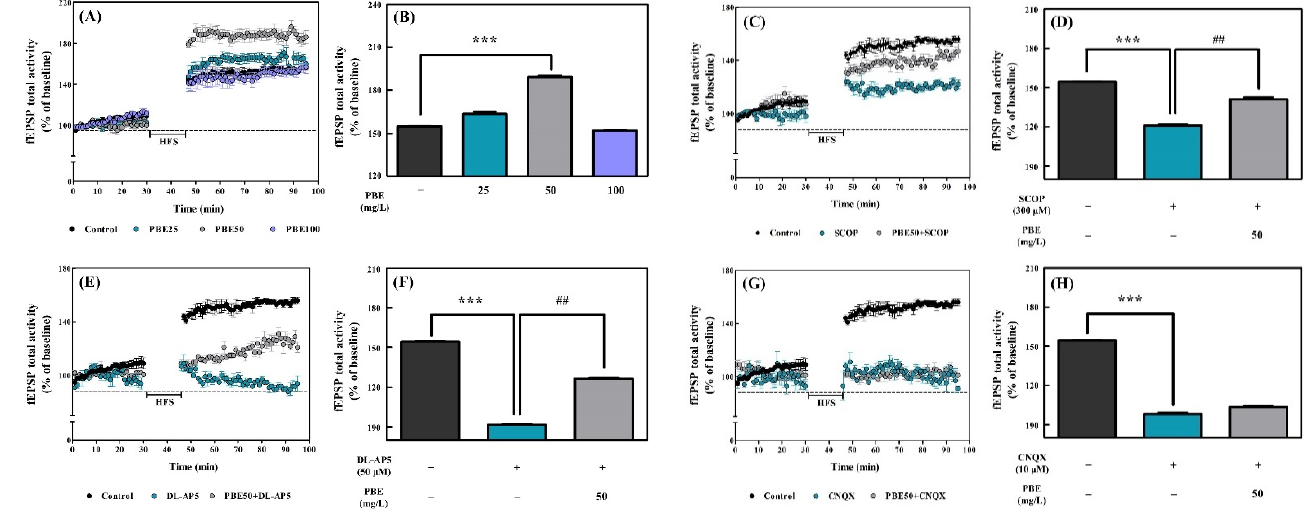
Figure 4. Effects of PBE, SCOP, DL-AP5, and CNQX on long-term potentiation (LTP) in organotypic hippocampal tissue from 7-day-old male SD rats (n = 6). ( A ) Time course of LTP from all recordings in control and PBE (25, 50, and 100 mg/L) groups, ( C ) time course of LTP in control, SCOP (300 μ M), and SCOP with 50 mg/L of PBE, ( E ) time course of LTP in the control, DL-AP5 (50 μ M) and DL-AP5 with PBE50, and ( G ) time course of LTP in the control, CNQX (10 μ M) and CNQX with PBE50. ( B , D , F , and H ) Average LTP amplitude measured at 30 − 40 min after high-frequency stimuli (HFS). fEPSP, field excitatory postsynaptic potential. Tukey’s honestly significant difference test: *** p < 0.001 vs. control and ## p < 0.01 vs. SCOP.